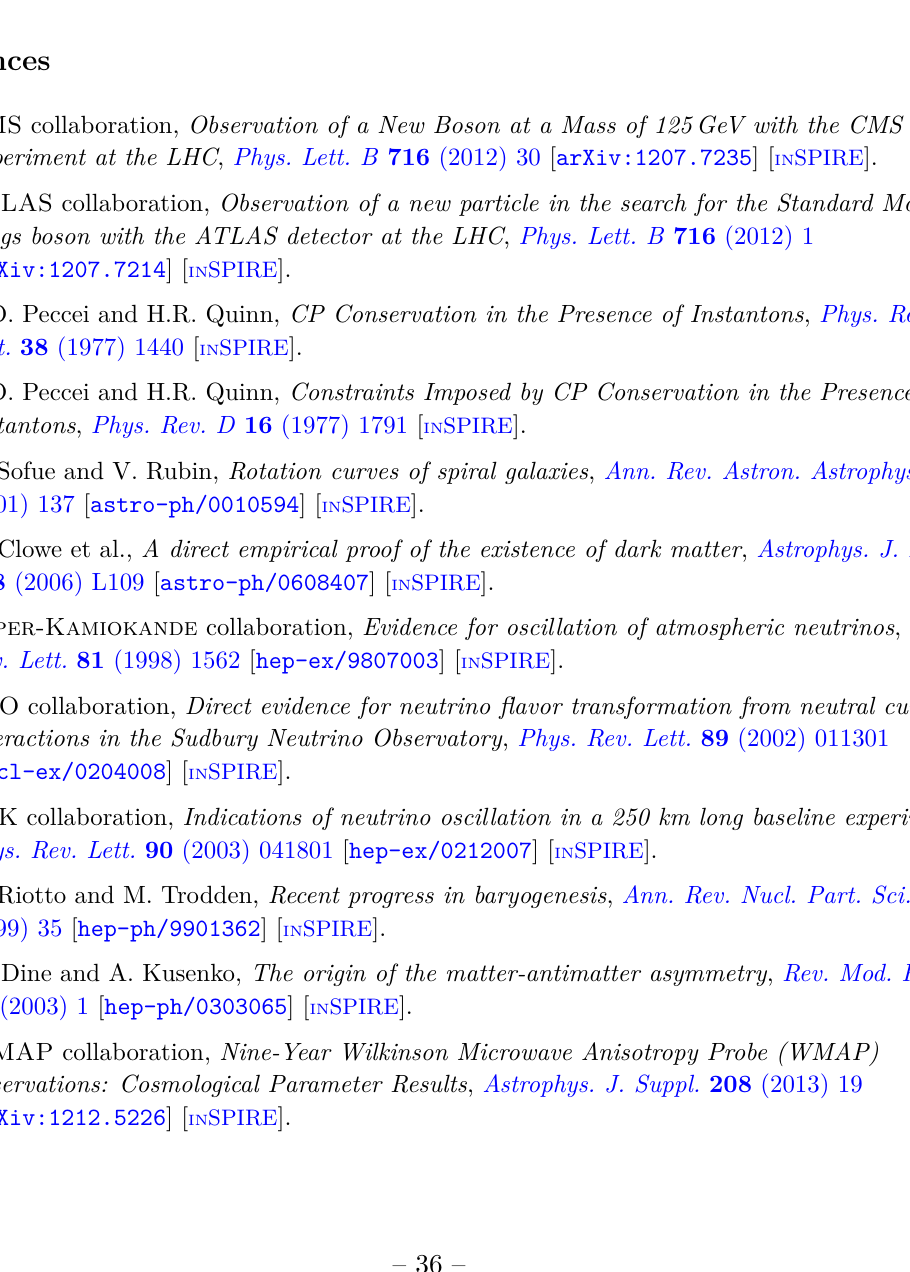
Figure 15. Diagrams contributing to the D 0 −